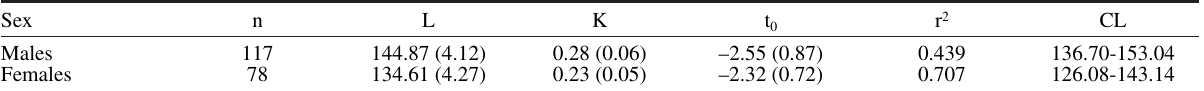
Table 3. – Von Bertalanffy growth parameters for males and females. CL, 95% confidence limits for L; K, growth rate (year –1 ); L, asymptotic length (mm); n, number of individuals; t , time (year). Values in brackets are standard errors. 0